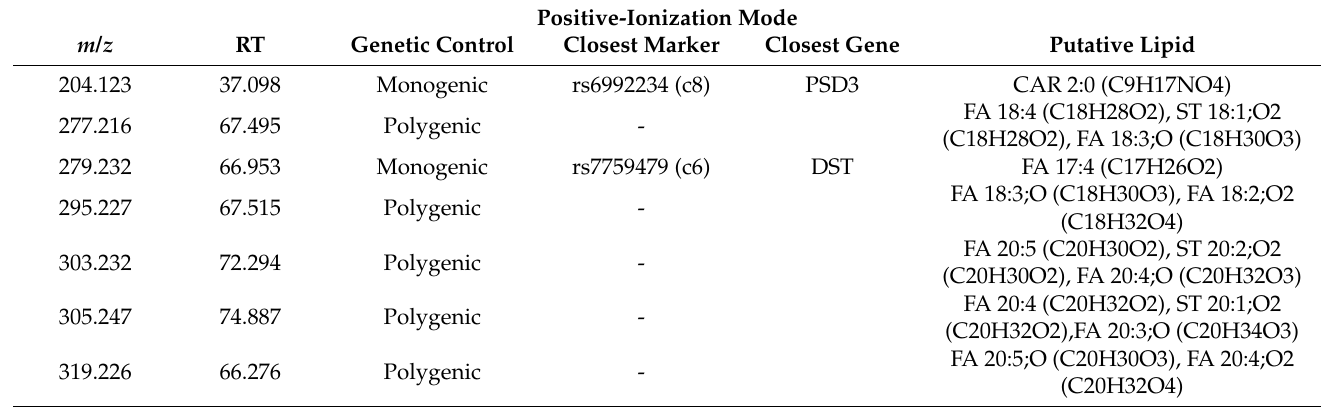
Figure 1. Genome-wide association study of metabolomic features (mGWAS) in the study group. Data are shown for metabolic features acquired in positive ( A ) and negative ( B ) ionization modes, showing evidence of significant association (LOD > 8) with an SNP locus. Chromosomes are color- coded on the circle. The colors of the lines indicate the chromosomal location of SNP loci showing evidence of significant association with metabolic features, characterized by a mass-to-charge ratio (horizontal axes). Details of genetic results are given in Supplementary Table S2. Table 3. Genetic control of lipidomic signals mapped to the genome and proposed lipid assignments. Lipidome data, acquired with a Q Exactive Hybrid Quadrupole-Orbitrap mass spectrometer fitted with a Waters Acquity CSH C18 column, were tested for genetic association with genotyped SNPs in the study group ( n = 273). Features were characterized by their retention time (RT) and their mass-to-charge ratio (m/z). Details of SNPs and statistical significance of lipidome features under monogenic control are reported. Full list of genetically mapped LC–MS lipidomic features and details and distinct SNP markers associated with lipid features under polygenic control are given in Supplementary Table 2. Candidate lipids proposed for lipidome features were identified through the LIPID MAPS Structure Database (https://www.lipidmaps.org, accessed on 4 June 2022). CAR, Acyl carnitine; DG, Diacylglycerol; FA, Fatty acyl; FOH, Fatty alcohol; LPA, Lipophosphatydicacid; LPC, Lysophosphatidylcholine; MG, Monoradylglycerol; NAE, N -acyl ethanolamine; PA, Phosphatidic acid; PC, Phosphatidylcholine; PE, Phosphatidylethanolamine; PS, Phosphatidylserine; ST, Sterol lipid; TG, Triacylgycerol; WE, Wax